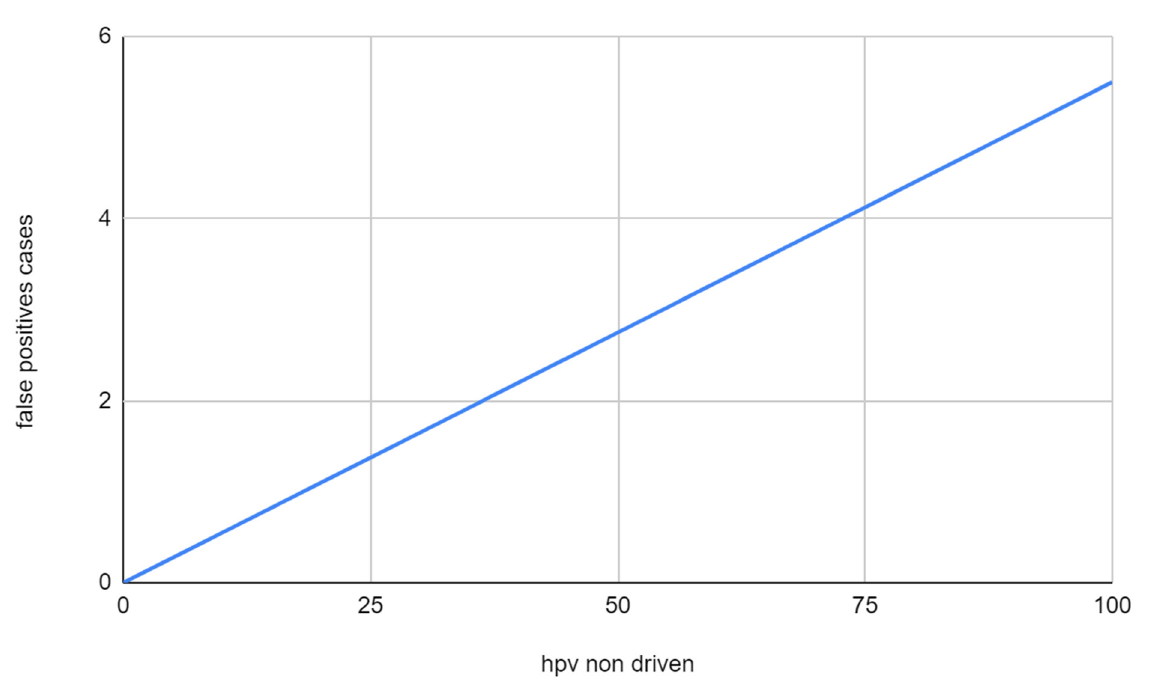
Figure 3. Graphical representation of the rate of false positive p16 IHC among OPSCC when the reference is the combination of p16IHC + genomic DNA PCR, according to the proportion of HPV non-driven OPSCCs in a given